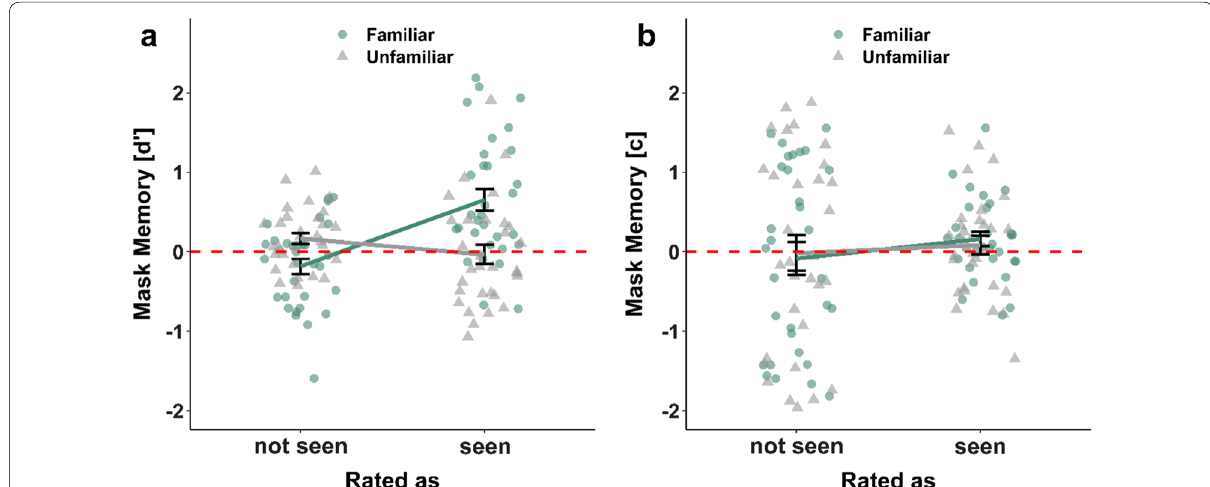
Fig. 6 Sensitivity ( d ′ ) and response bias ( c ) for mask memory (Question 2). Note. Error bars indicate standard errors. Each data point shows the sensitivity ( d ′ ; panel a ) or response bias ( c ; panel b ) of a participant indicating whether they saw a mask in the study phase, separately for cases in which they rated the faces as seen or not seen in the study phase and familiar (blue dots) or unfamiliar faces (gray dots). a Main effects of familiarity and rating on memory sensitivity for masks. Higher values of d ′ indicate better performance. A value of zero indicates ‘guessing.’ b Main effects of familiarity and rating on memory bias for masks. Values greater than zero indicate a conservative bias (tendency to answer ‘no’), and values lower than zero indicate a liberal bias (tendency to answer ‘yes’)